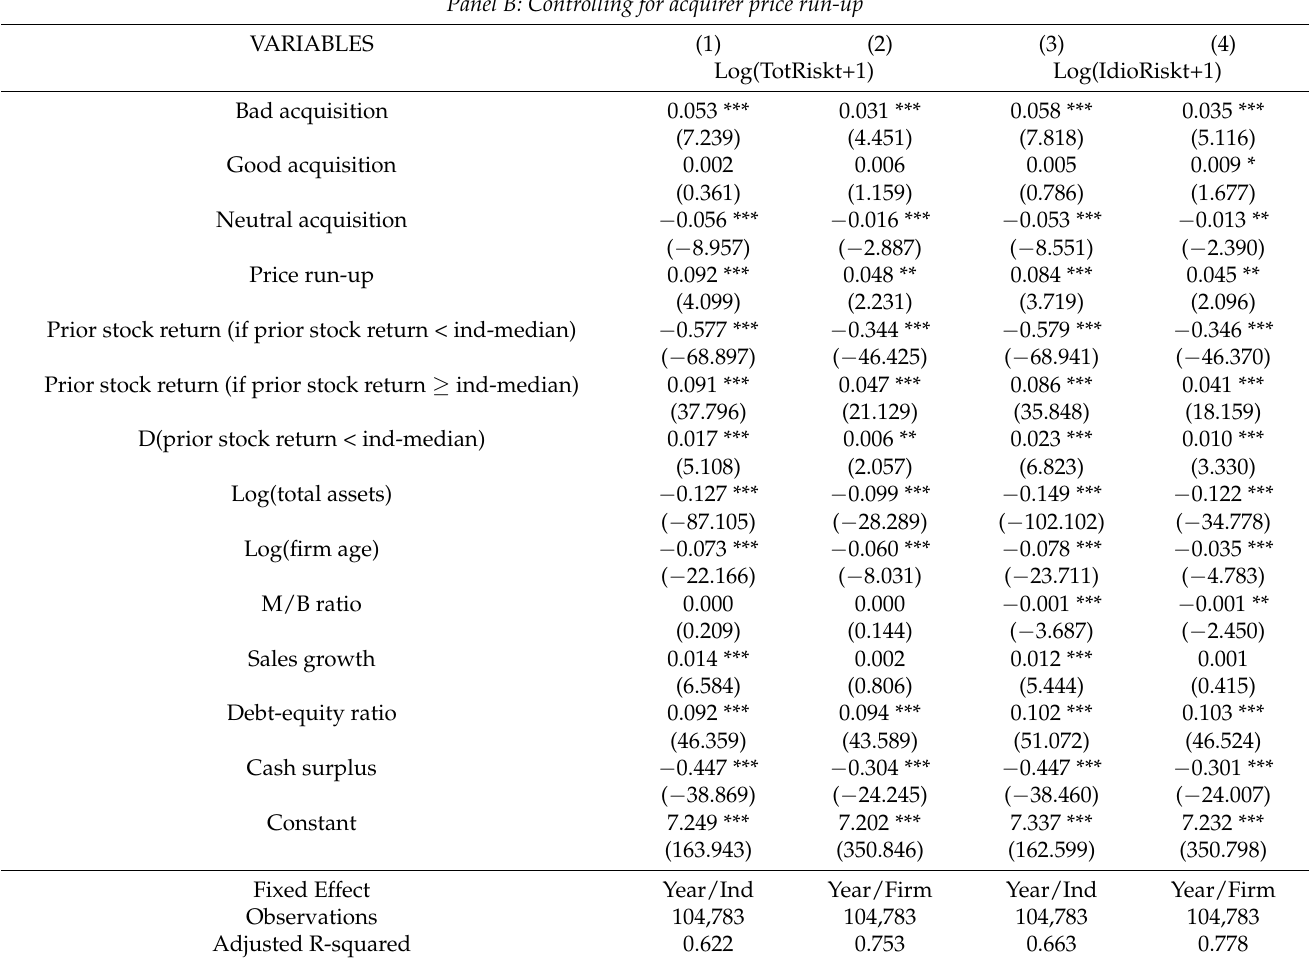
Panel B: Controlling for acquirer price